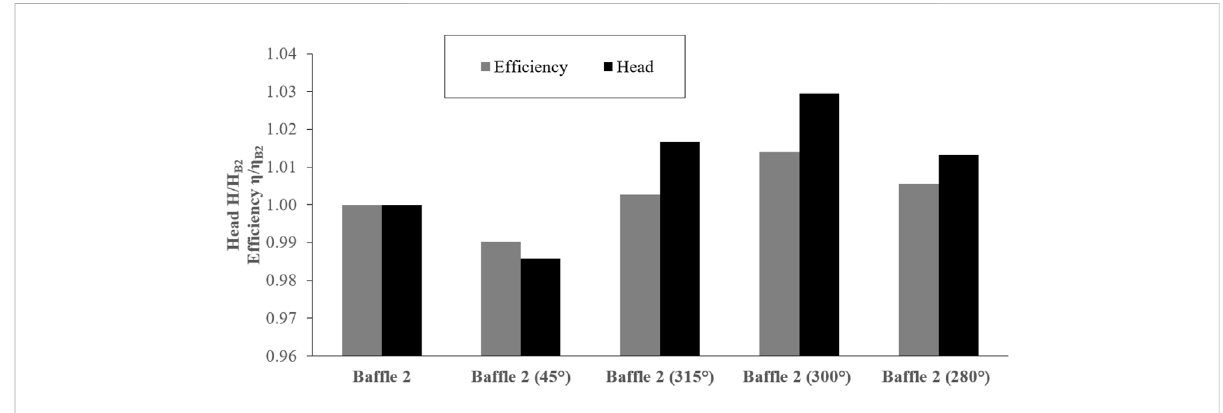
FIGURE 14 Ef fi ciency and head comparison of baf fl e 2 design at various angles.